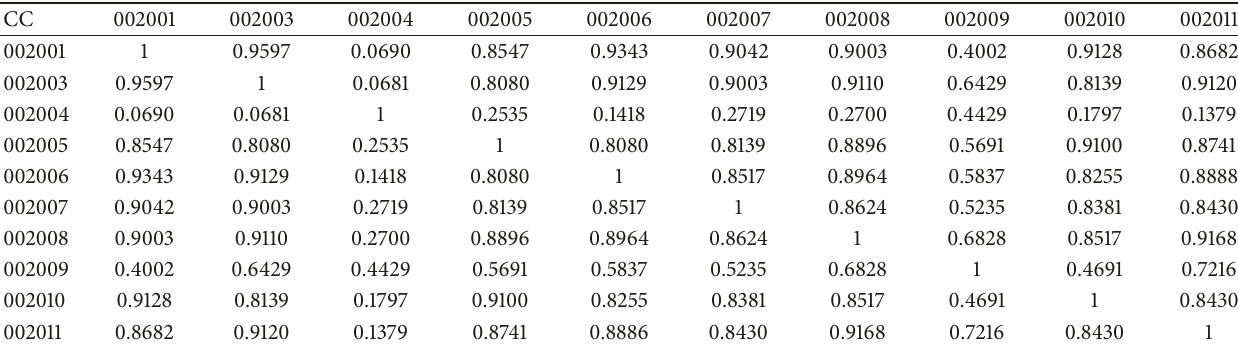
Table 4: Prediction correlation matrix.